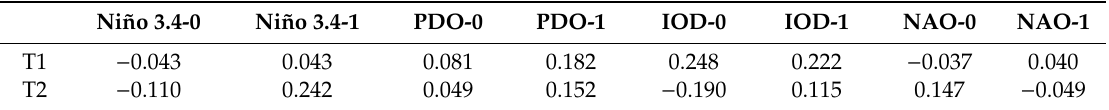
Table 3. Correlation coe ffi cients between ENSO, the Pacific Decadal Oscillation (PDO), the Indian Ocean Dipole (IDO), the North Atlantic Oscillation (NAO), T1 and T2. Niño